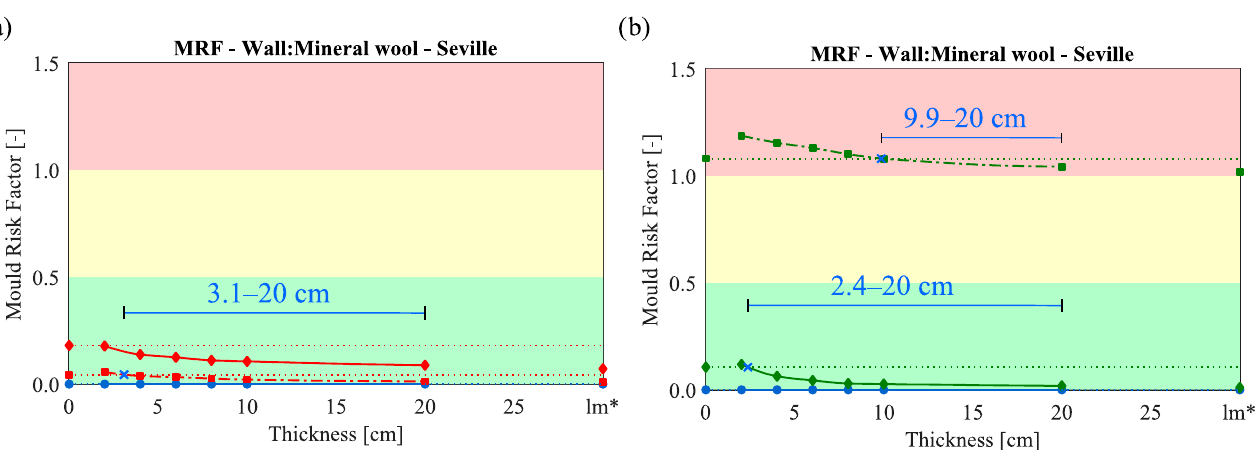
Figure 7. Recommended thickness ranges for mineral wool retrofit if the world evolves as described in RCP 4.5 ( a ), in the near future (NF) and far future (FF) for MRF, or as described in RCP 8.5 ( b ), in the near future (NF) and far future (FF) for MRF. lm* is an additional “virtual” thickness that corresponds to a 30 cm layer